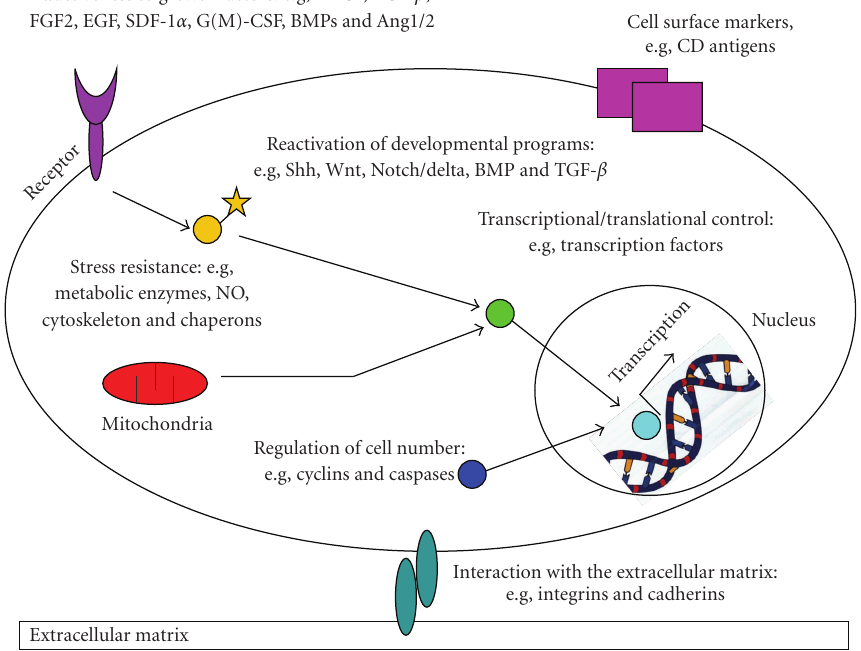
Figure 4: Proteomic definition of MSCs—proposal for the protein inventory. The main aspects for a proteomic definition of MSCs